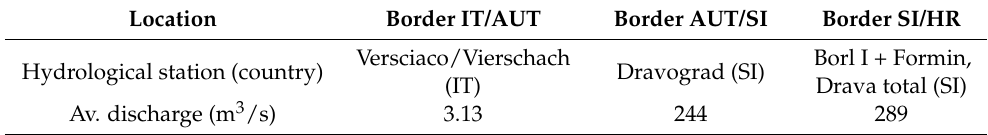
Table 2. Drava’s mean inflows from the upstream countries during 1991–2010 period. Location Border IT/AUT Border AUT/SI Border SI/HR Hydrological station (country)